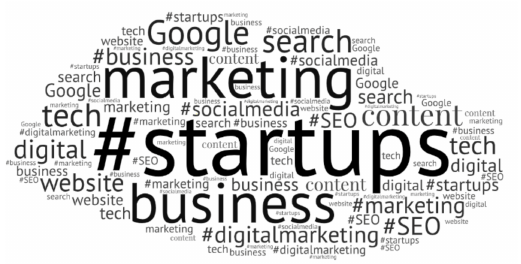
Figure 1. Most popular words and hashtags found in the